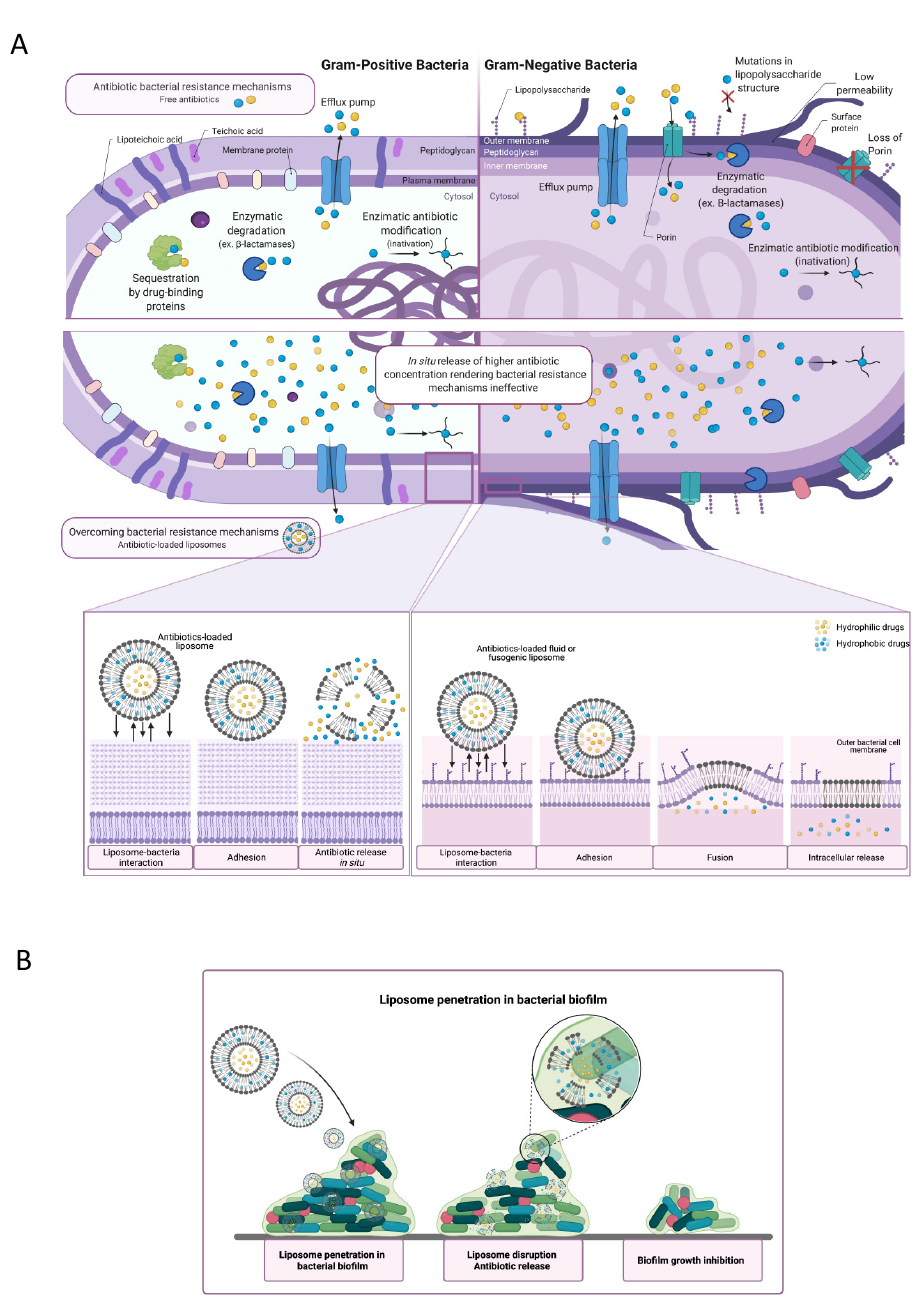
Figure 3. Schematic representation of antimicrobial resistance mechanisms that could be overcome by the use of antibiotic incorporated liposomes. ( A ) There are several mechanisms of antibiotic resistance, including loss of porins, which reduce the antibiotic entrance; sequestration of the antibiotics by drug binding proteins, blocking its interaction with the target; enzymatic degradation and enzymatic antibiotic modification, which alter the antibiotic making it incapable of inducing its effect; and efflux pumps which expels the antibiotic out of the cell. Blue and yellow spheres indicate antibiotics. The encapsulation of antibiotics provides the delivery of a higher antibiotic concentration within the bacteria infection site possibly stimulating the fusion with the bacterial membrane depending on the lipid composition. By increasing the antibiotic concentration, the resistance mechanisms depicted become obsolete, unable to fully block the antibiotic action. Mechanisms not shown include target modification, target bypass and antibiotic target protection. ( B ) Liposome penetration in biofilm: biofilms are considered a resistance mechanism due to the lower penetrability of the antibiotic in the extracellular matrix. Antibiotic-loaded liposomes have the ability to interact with bacteria organized in biofilm, enabling the antibiotic delivery within its